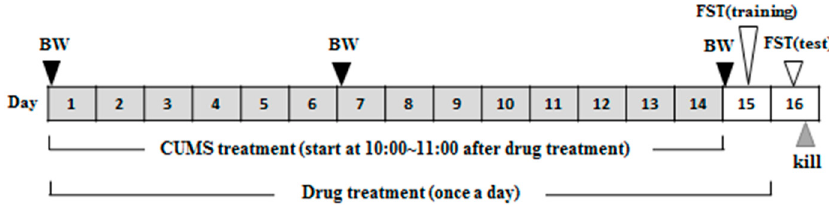
Figure 10. Schematic drawing of experimental schedule. BW means measurement of body weight.